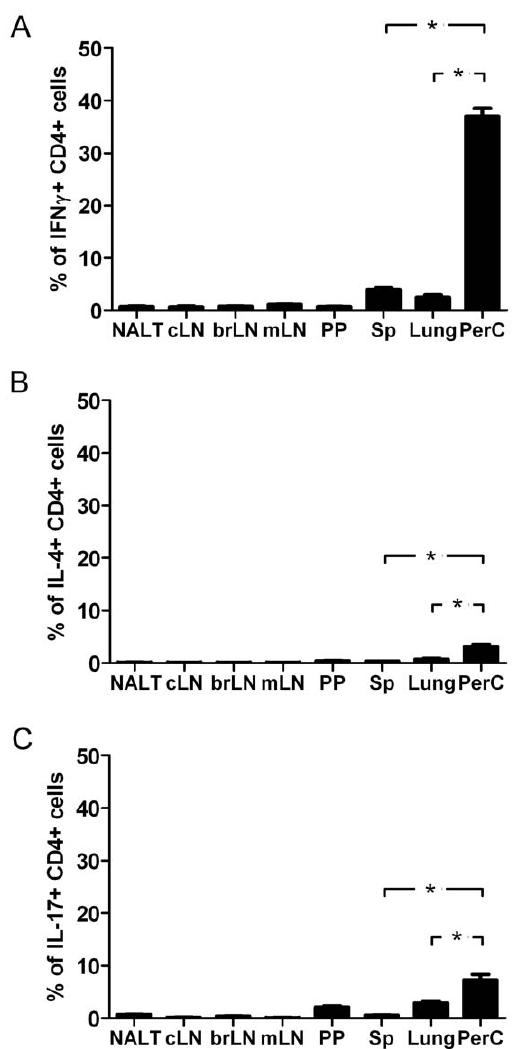
different anatomic niches. The percentage of different Th cell subsets in CD4 + cell population were determined by FACS analysis in different organs (n=5). (A) Th1 cells (IFN c secreting cells), (B) Th2 cells (IL-4 secreting cells) and (C) Th17 cells (IL-17 secreting cells). The differences were statistically significant at P , 0.001 (*). Similar results were obtained in 2 independent experiments. NALT, nasal associated lymphoid tissues; cLN, cervical lymph node; brLN, bronchial lymph nodes; mLN, mesenteric lymph node; PP, Peyer’s patches; Sp, spleen; PerC, peritoneal cavity.